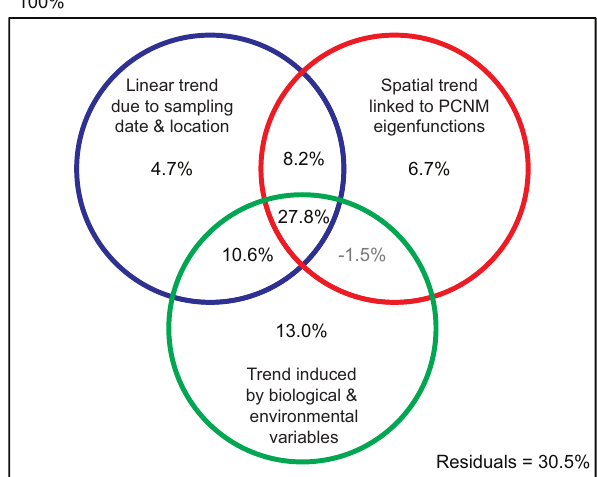
Fig. 16. Variation partitioning analysis of the vertical POC fluxes derived from the UVP5 dataset (154 stations, 17 size classes, all in- tegrated over the top 200m of the water column) as based on redun- dancy analyses of three sets of explanatory variables (Fig. 14). The content of reduced models of explanatory variables is detailed in Table 4. The negative percentage between the red and green circles means that the contributions from these two fractions when taken separately are larger than their partial contributions (i.e., their in- teraction). PCNM: principal coordinates of neighbor matrices (Bor- card et al.,